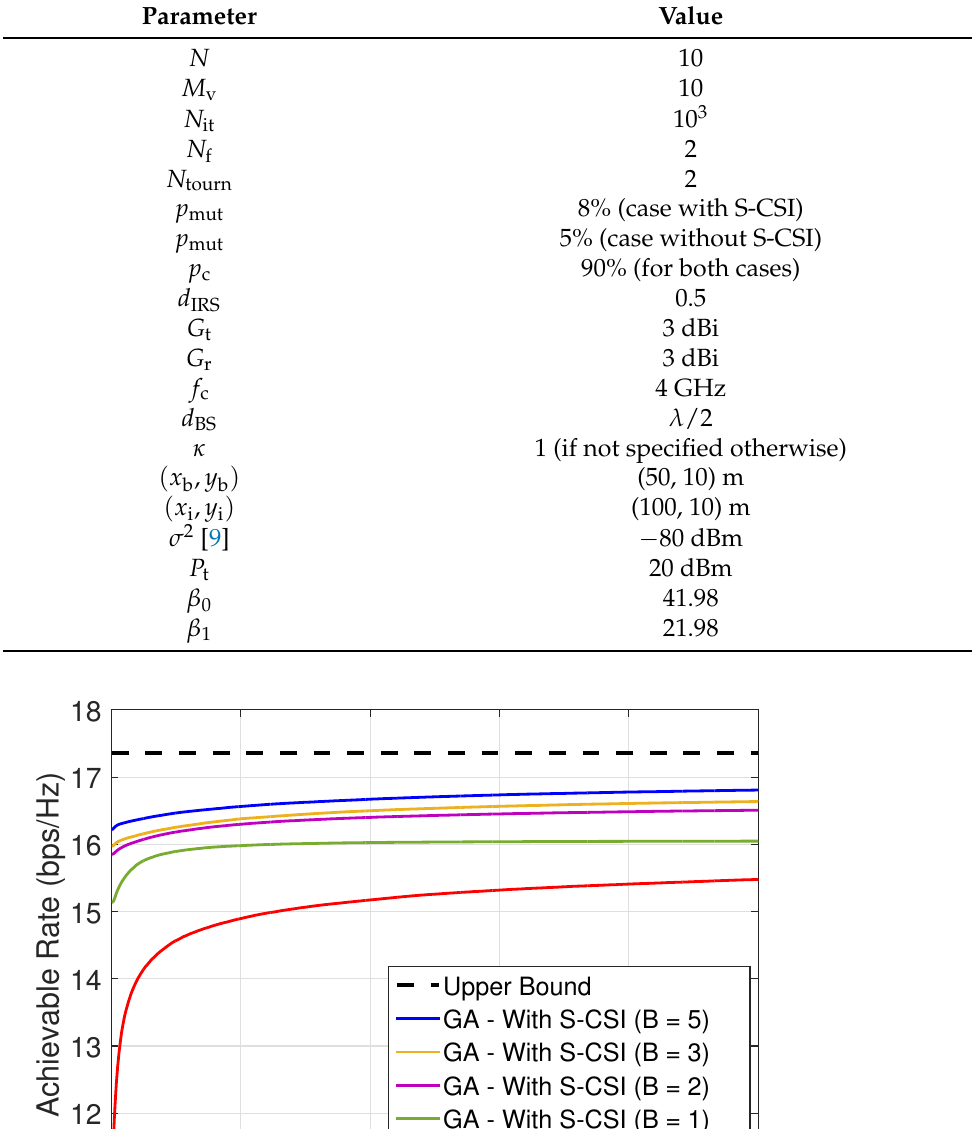
Table 2. Simulation parameters.